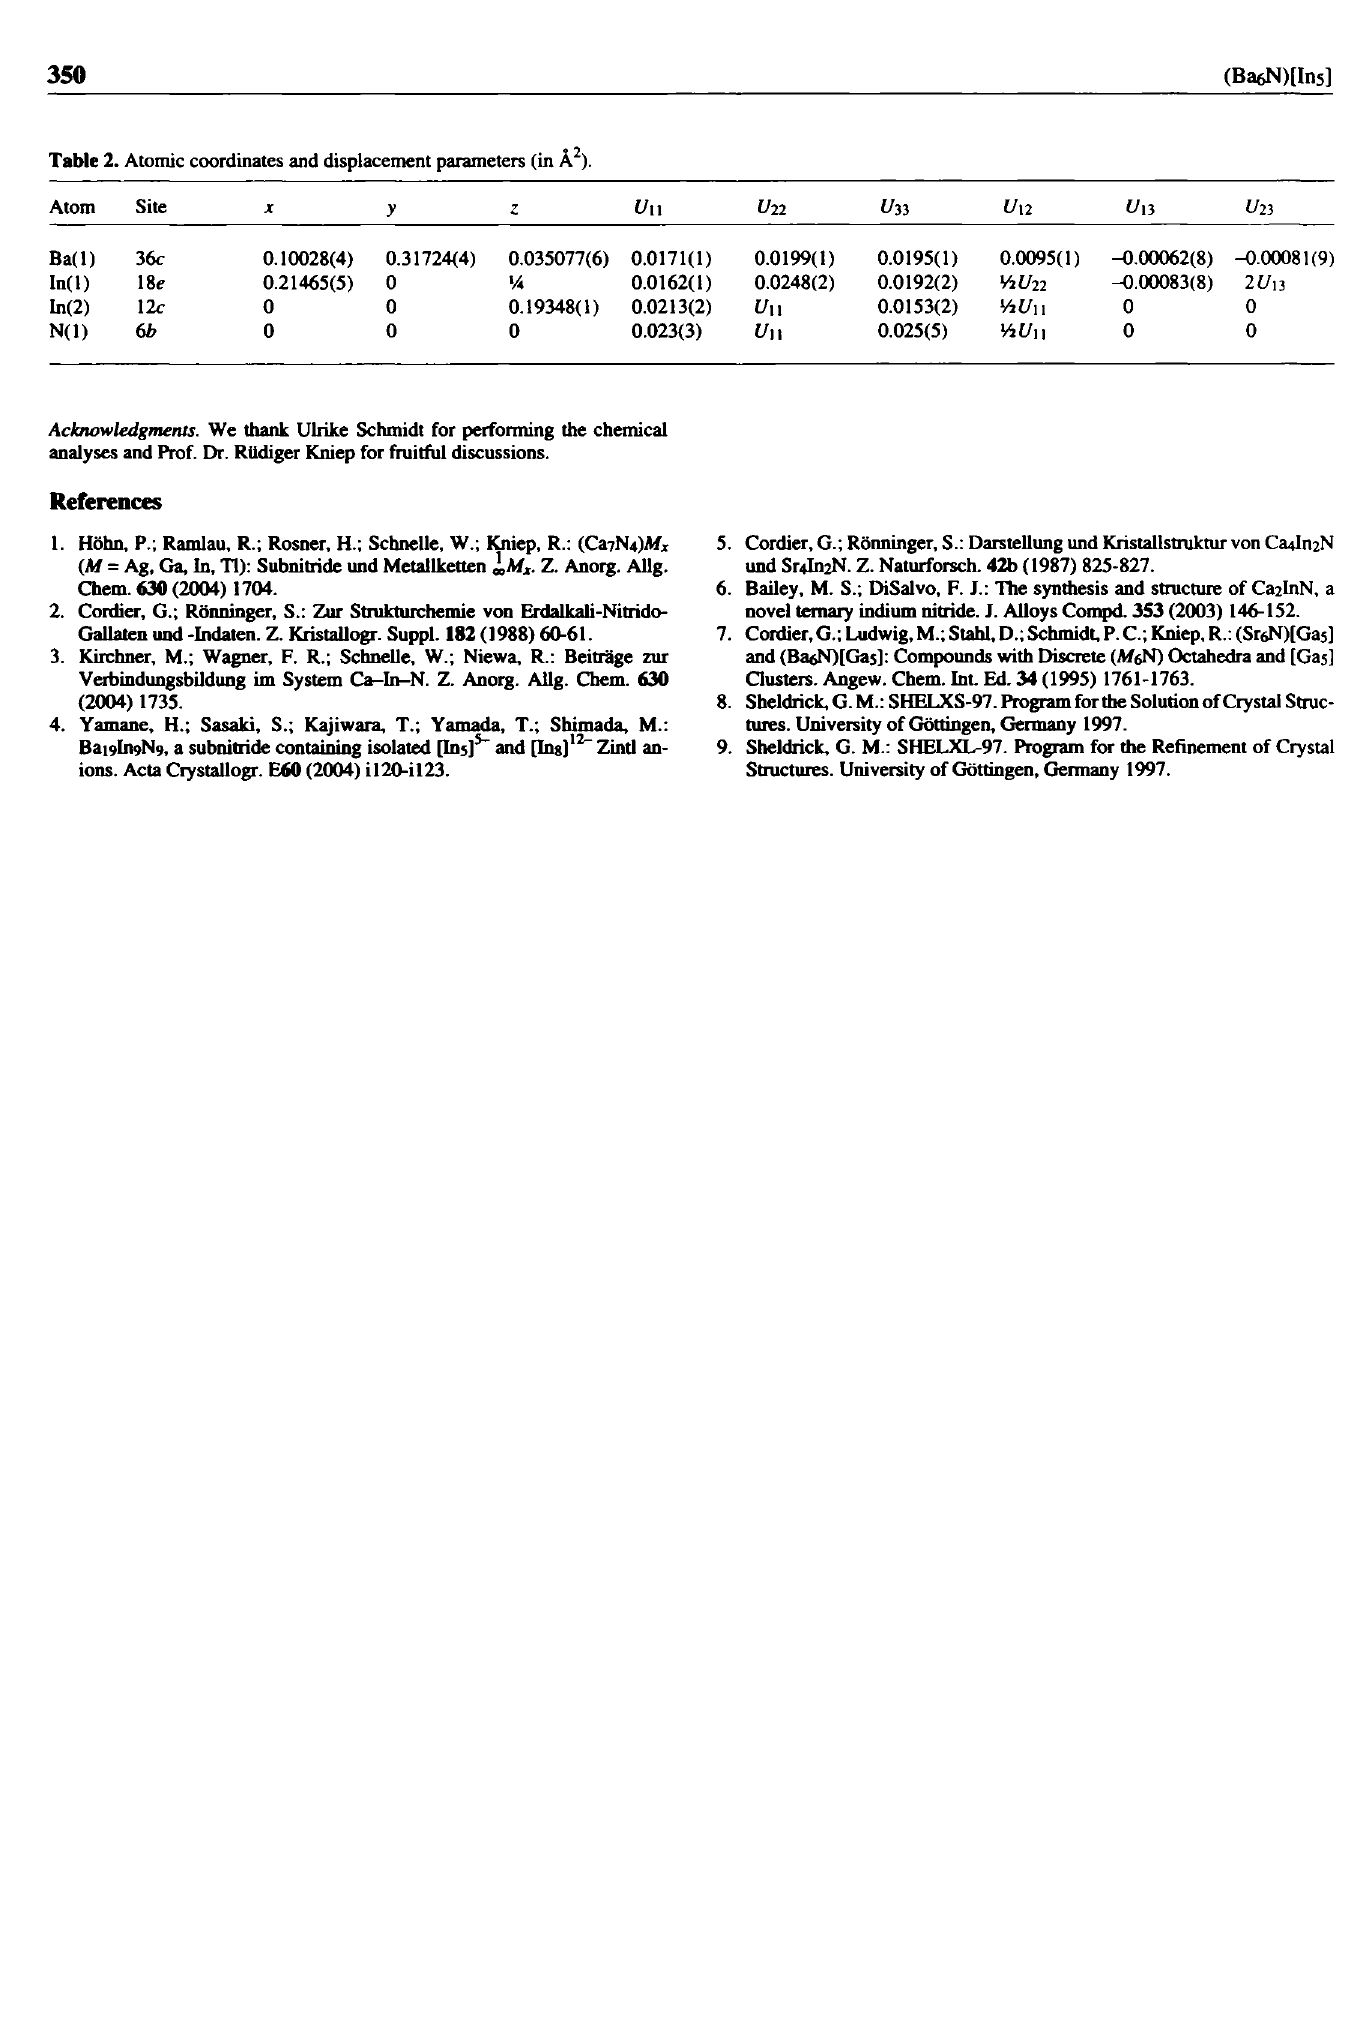
Table 2. Atomic coordinates and displacement parameters (in Â 2